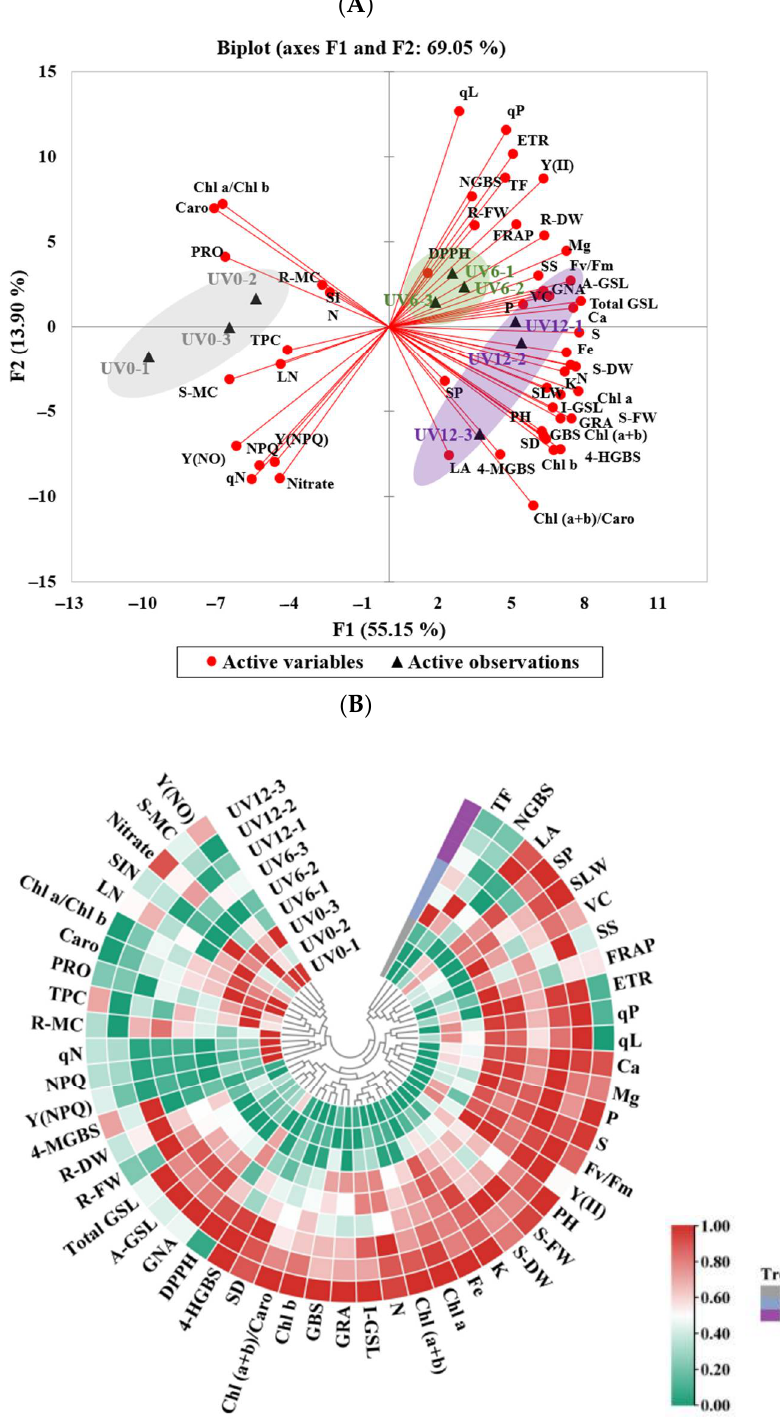
Figure 11. Principal component ( A ) and heatmap ( B ) analyses showed differences and correlations in the investigated parameters in Chinese kale subjected to different durations of UVA-radiation exposure. Results are visualized using a false-color scale, with red and green indicating an increase and a decrease in the response parameters.